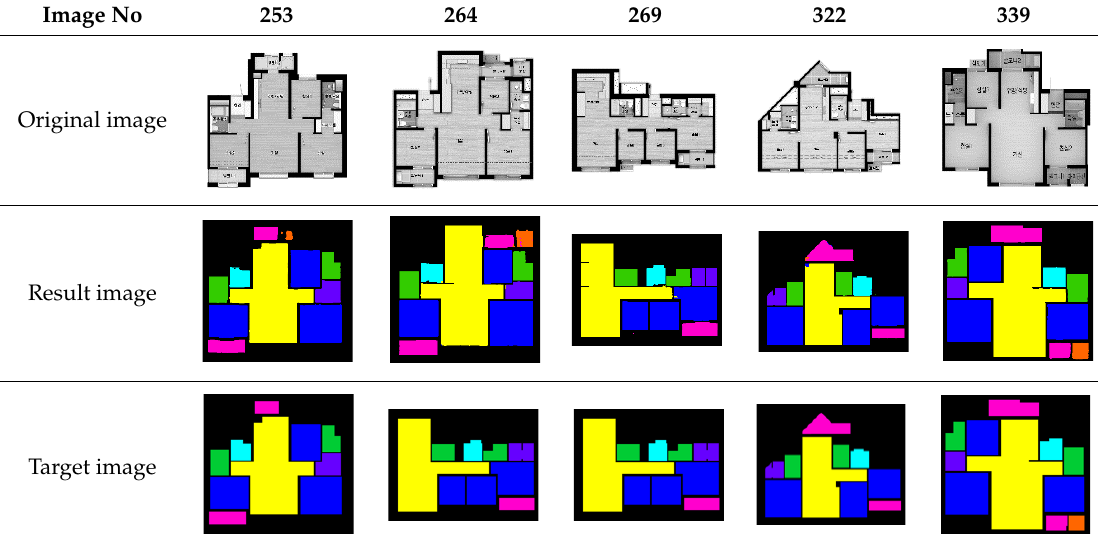
Table 4. Original image, result image, target image of experiment2.